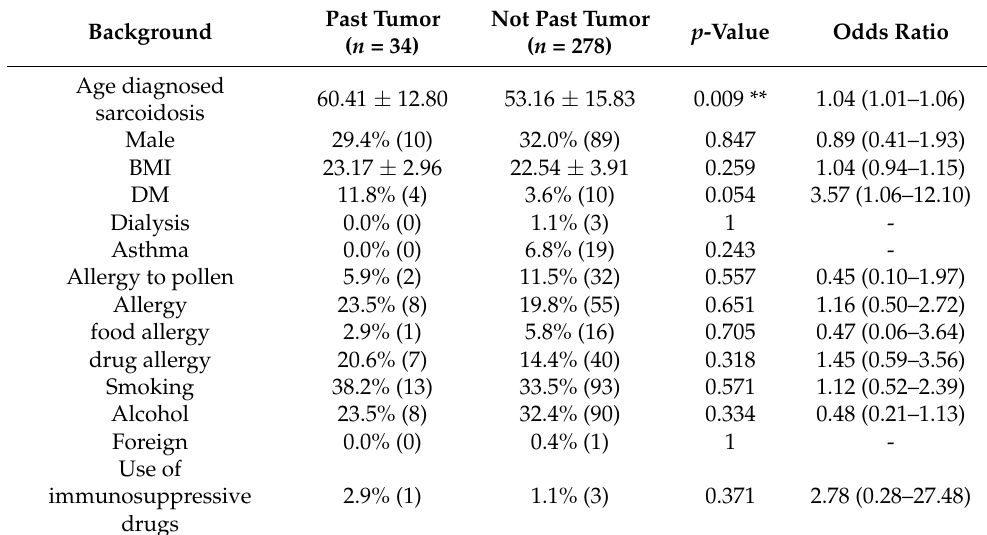
Table 5. Comparison between patients with sarcoidosis that did or did not have a tumor